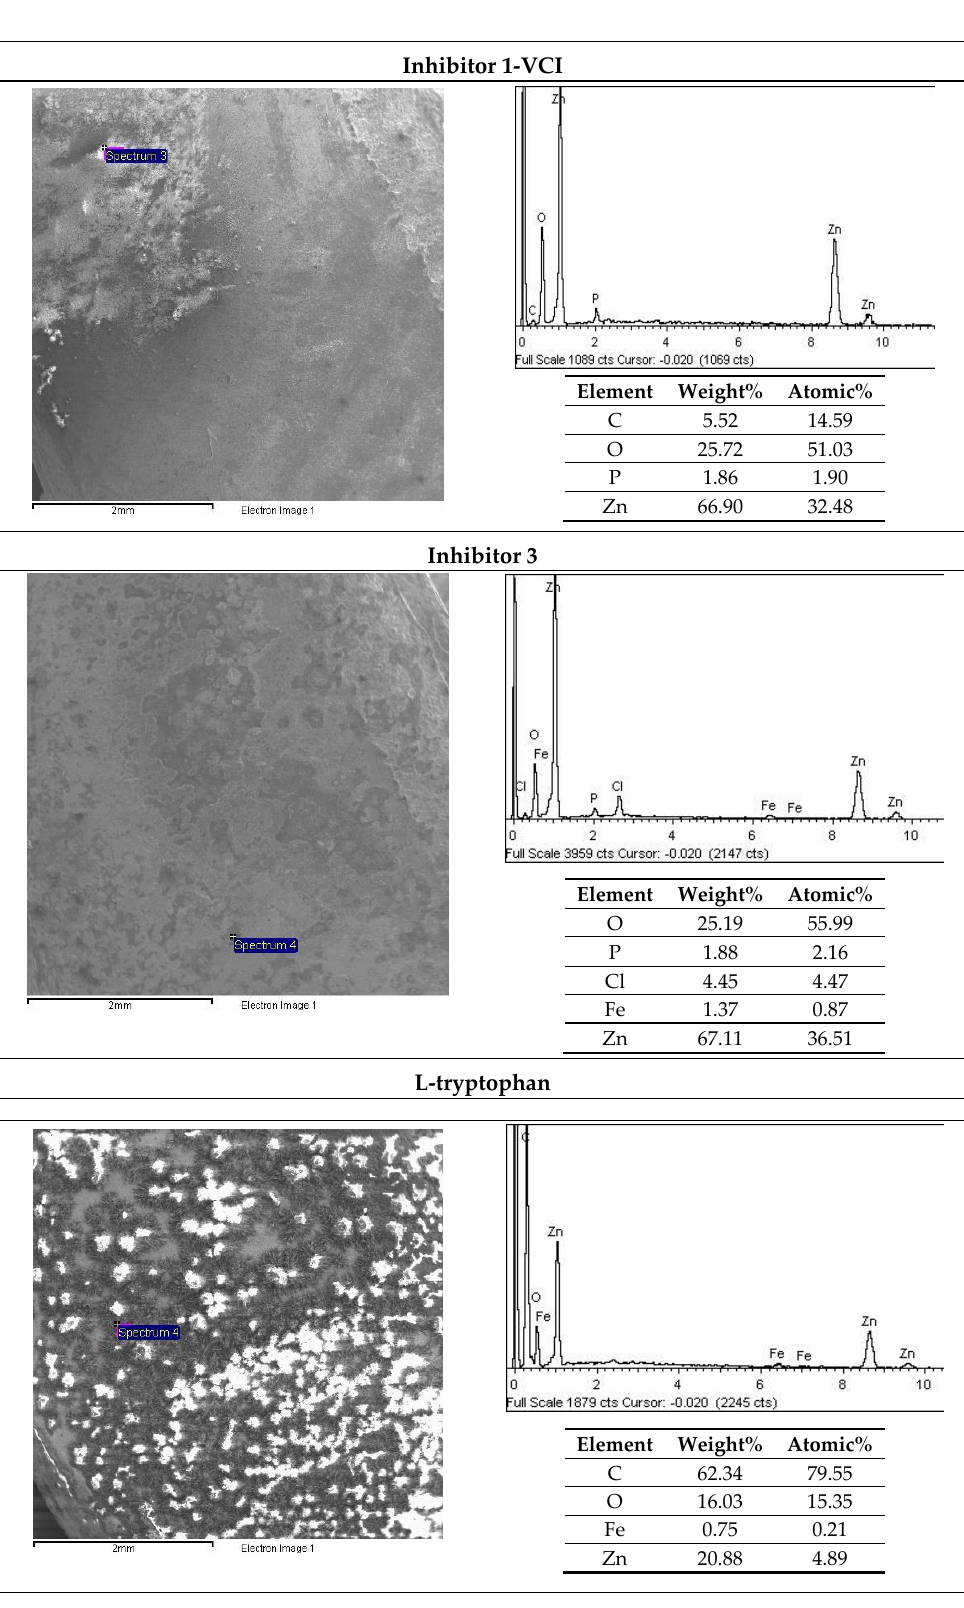
Figure 12. SEM and EDX view of inhibitor layer after 24 h in distilled water.